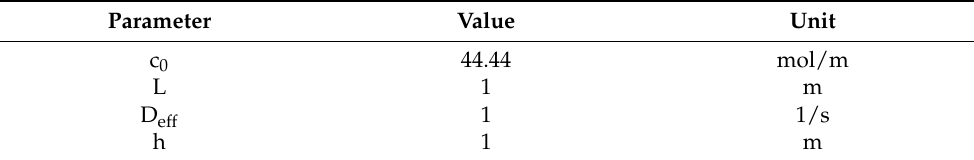
Table 2. Parameter values used for the visualized analytical solution.